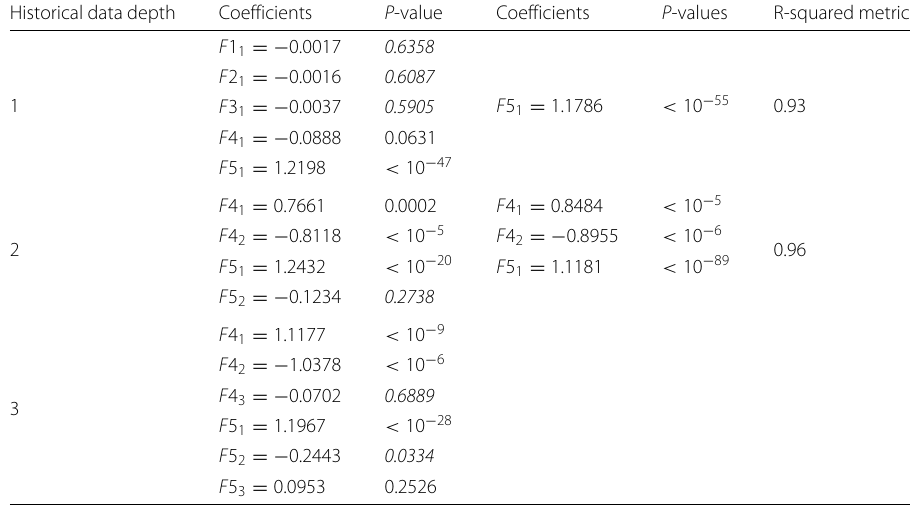
Table 2 Performance of different set of features on predicting the crime per capita for 2017 Historical data depth Coefficients P -value Coefficients P